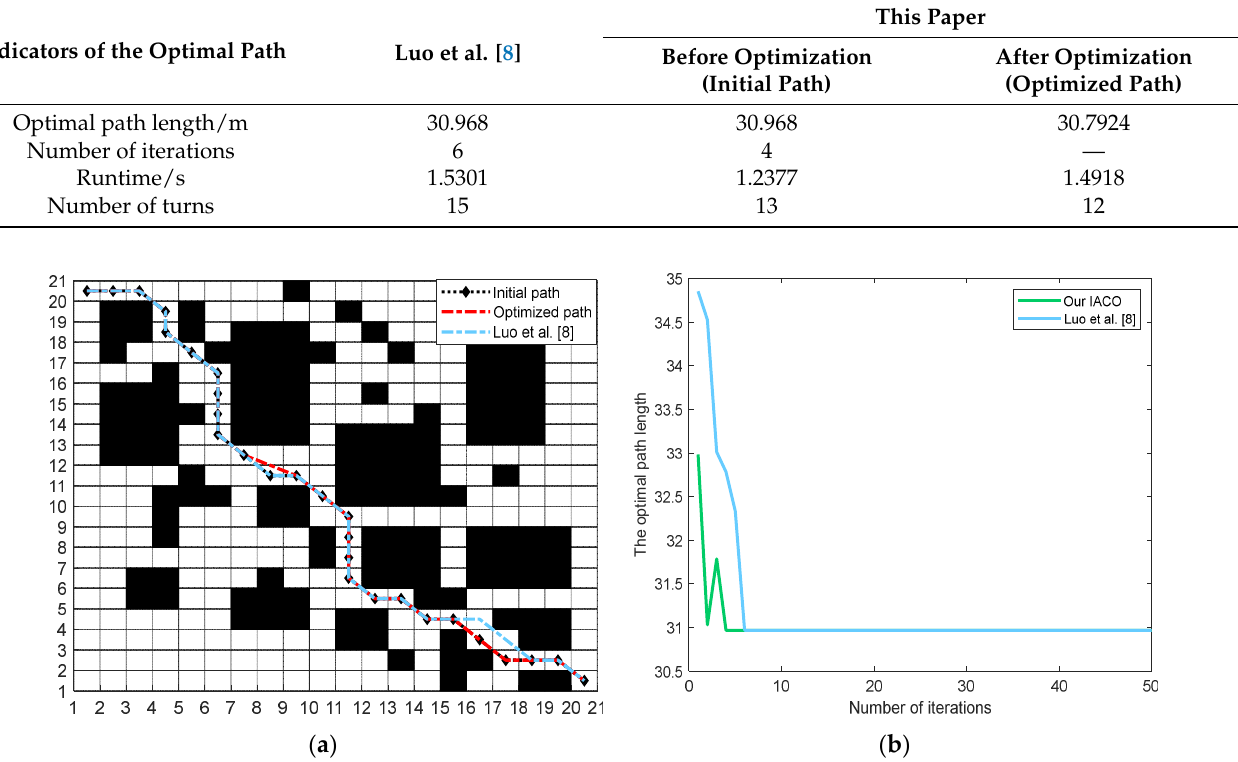
Figure 12. Comparison experiment 1. ( a ) Path planning. ( b ) Convergence curve. Table 4. Comparison of the results of the two algorithms in global path planning.